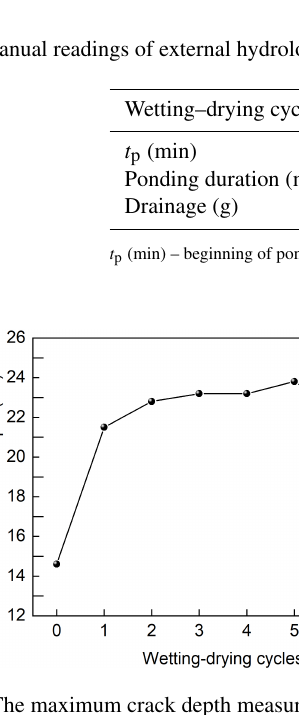
Figure 7. The maximum crack depth measured after each wetting– drying